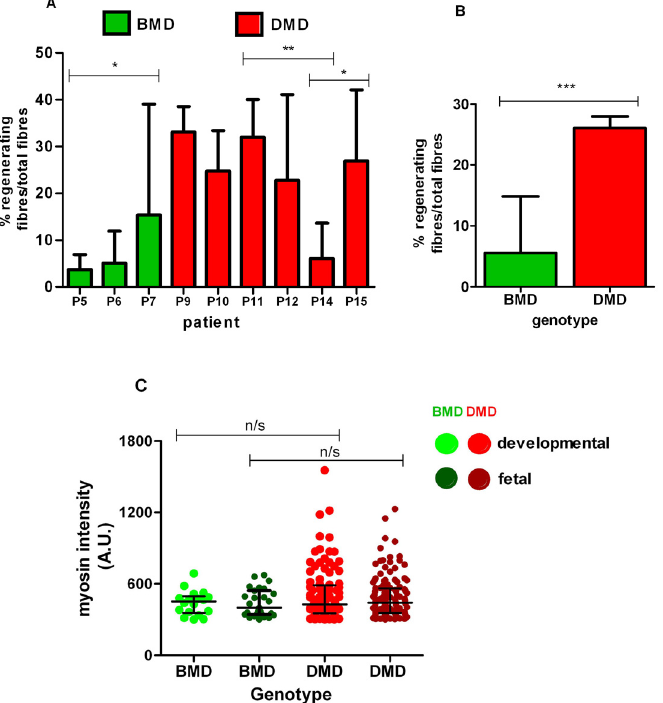
Fig 5. Quantification of regeneration in BMD and DMD. (A) Regenerating myofibres (i.e. fetal and developmental myosin positive), quantified in 3 BMD (green) and 6 DMD (red) muscle biopsies show variable regeneration levels in BMD. Counts obtained from 10 random fields (except P7 and P9 where 9 fields from each were quantified) and expressed as a percentage of the total number of fibres. (B) Pooled analysis of total regenerating fibres showed double the number in DMD compared to BMD and (C) increased mean intensity of both myosins was seen in DMD ((n = 100), developmental; (n = 124), fetal total fibres) compared to BMD ((n = 18), developmental; (n = 27), fetal total fibres analysed) muscle fibres when sections were stained with either fetal or developmental myosin only. No regenerating fibres were present in BMD muscle section P5. Kruskal-Wallis followed by Dunn ’ s test performed (median and IQR depicted; * p < 0.05; ** p < 0.01; *** p < 0.001, n/s — not